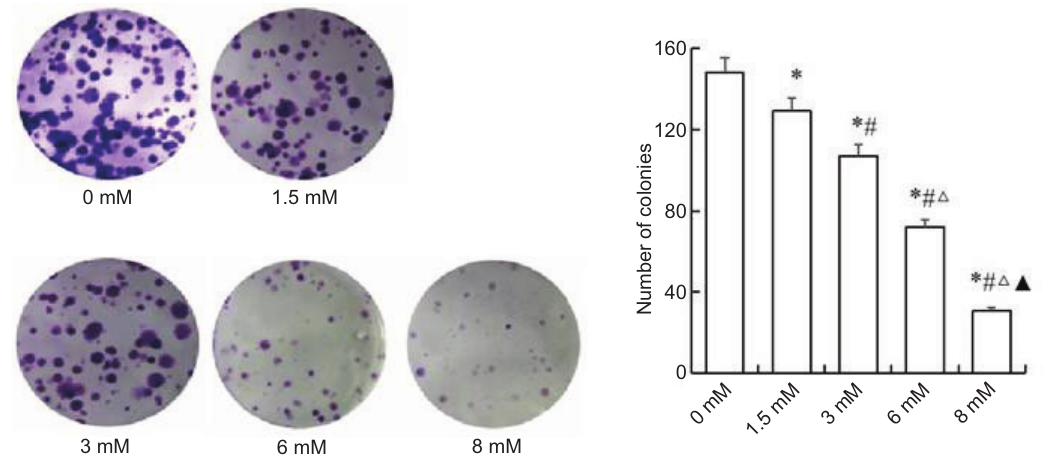
Figure 3: Tumor cell clone formation assays. ligustrazine significantly reduced colony-forming efficiency in a dose-dependent